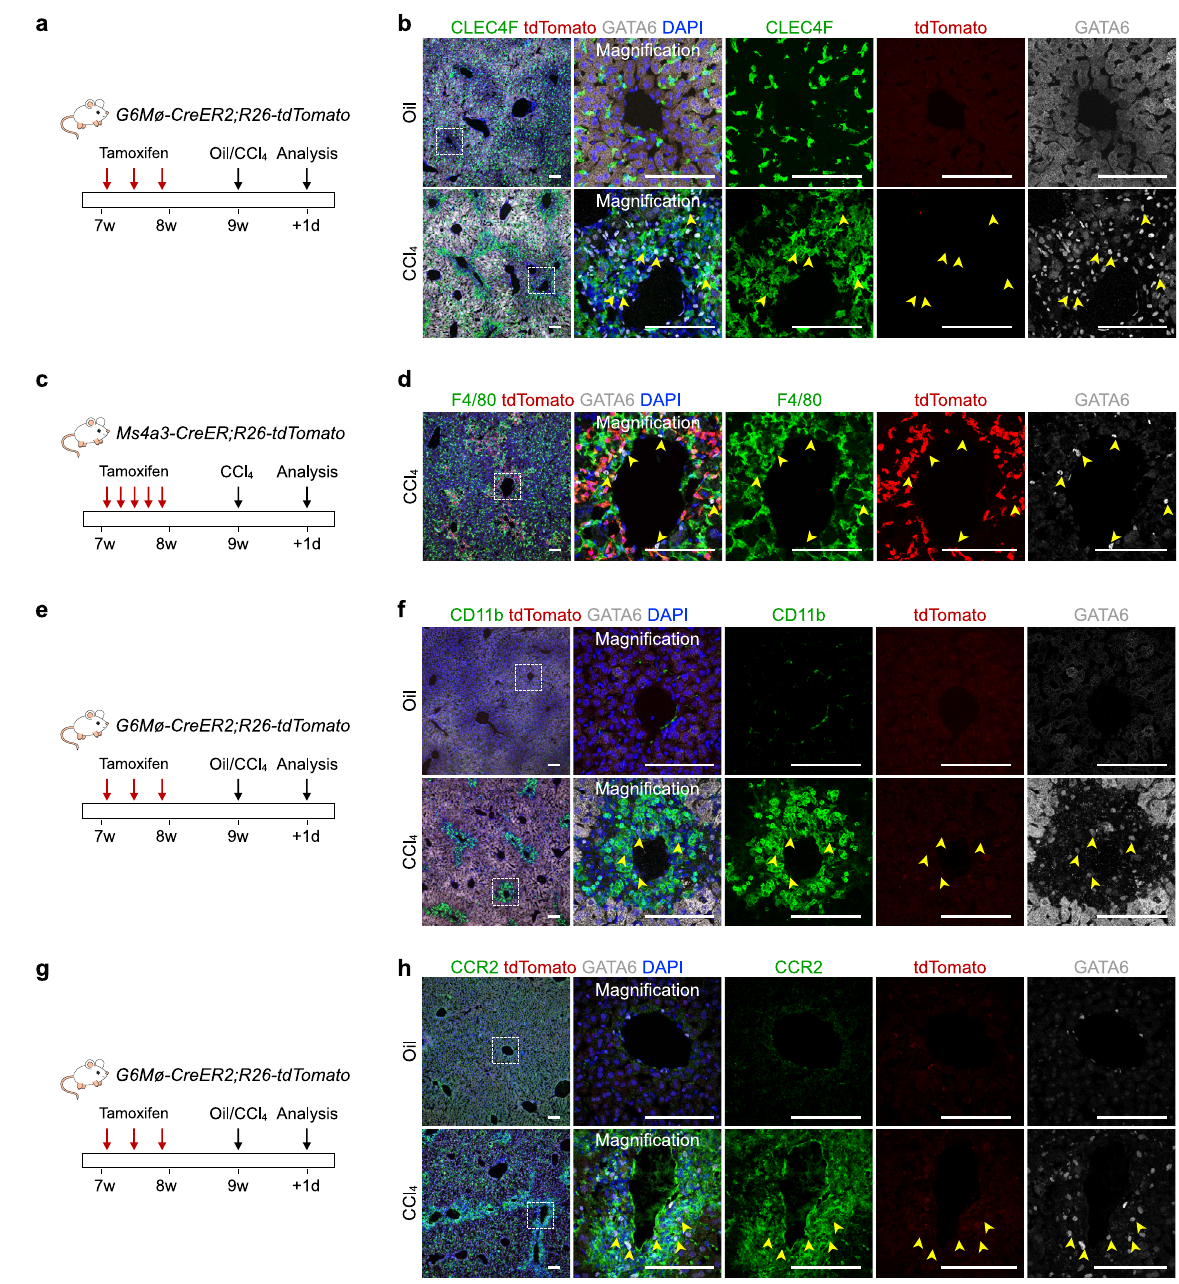
Fig. 7 GATA6 + tdTomato − cells in the CCl 4 -treated livers are mainly resident Kupffer cells. a Schematic fi gure showing experimental strategy. b Immunostaining for tdTomato, GATA6, and CLEC4F on liver sections. c Schematic fi gure showing experimental strategy. d Immunostaining for tdTomato, GATA6, and F4/80 on the injured region of the liver section. e Schematic fi gure showing experimental strategy. f Immunostaining for tdTomato, GATA6, and CD11b on liver sections. g Schematic fi gure showing experimental strategy. h Immunostaining for tdTomato, GATA6, and CCR2 on liver sections. Scale bars, 100 µ m. For b , d , f , h arrowheads indicate GATA6 + cells after injury. Boxed regions are magni fi ed. Each image is representative of fi ve individual